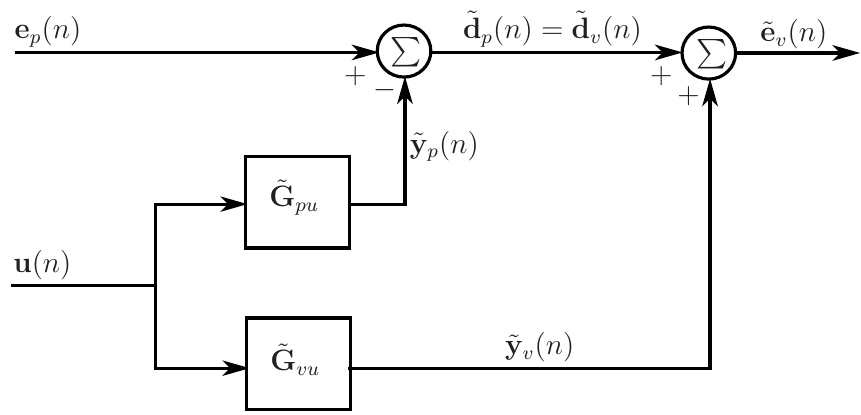
Figure 2 . Block diagram of the virtual microphone arrangement.